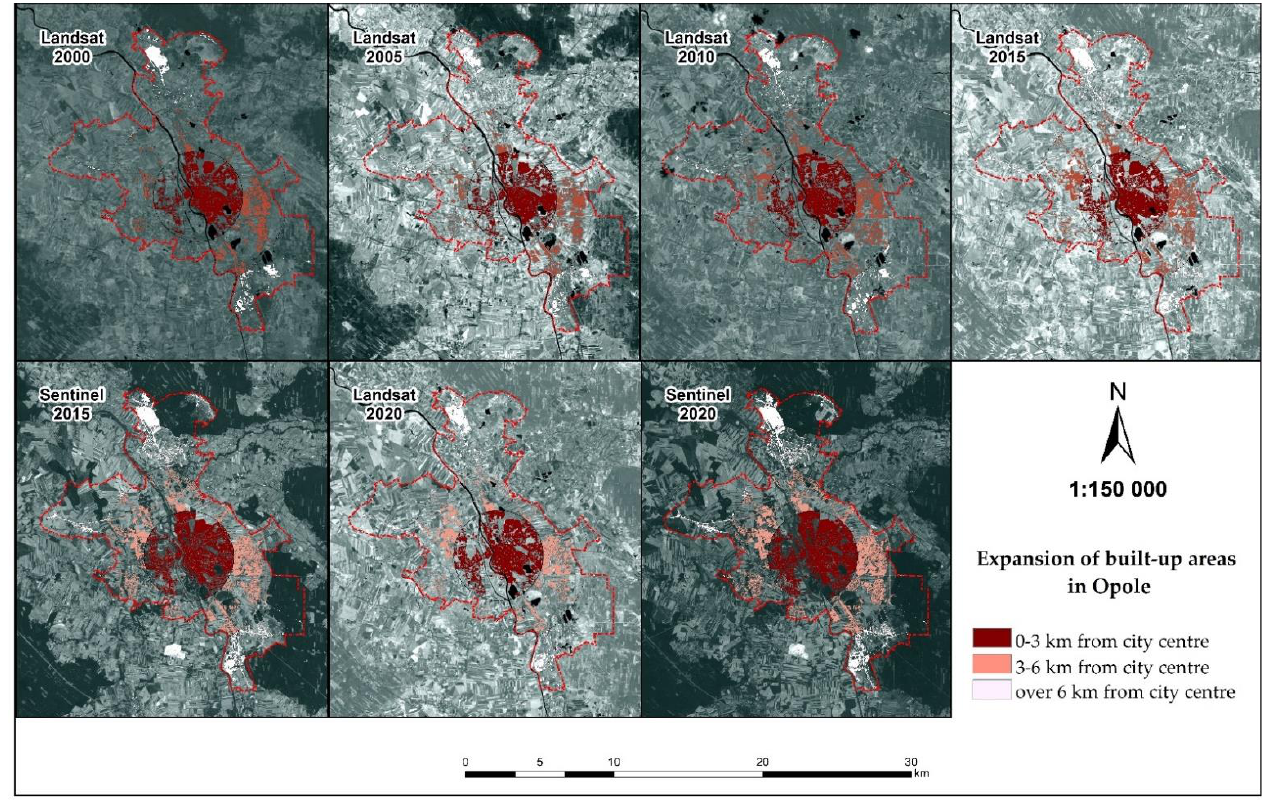
Figure 3. The growth and expansion of built-up areas from the city centre to the periphery of Opole from 2000–2020.